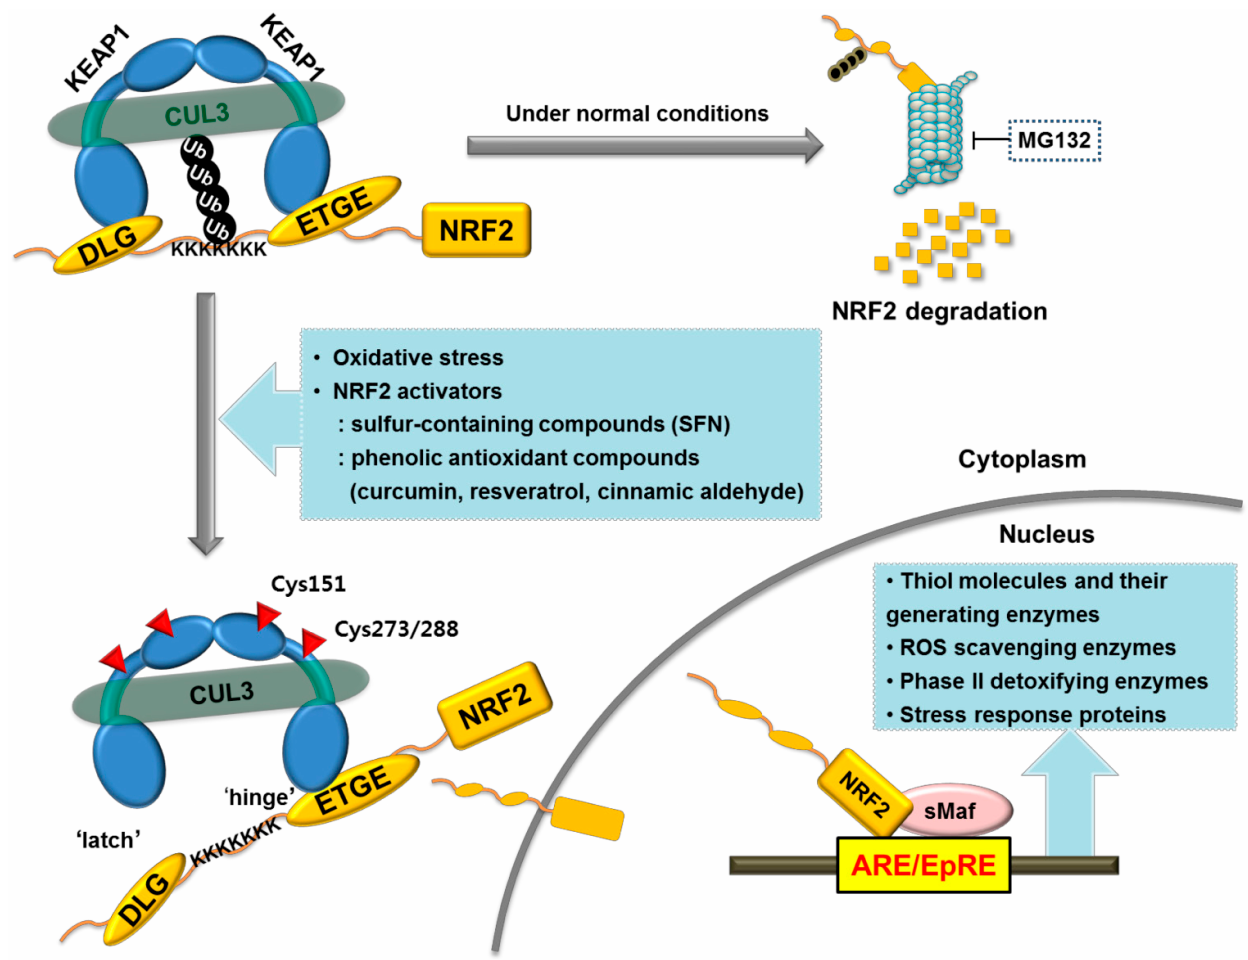
Figure 1. Regulation of antioxidant and detoxifying genes by the NRF2-Keap1 pathway. Under normal conditions, NRF2 is continuously degraded by the KEAP1-Cul3-proteasome axis. When Cys residues of KEAP1 protein are modified by sulfhydryl reactive chemicals, conformational KEAP1 changes lead to NRF2 liberation and transcriptional activation of an array of ARE-bearing genes, encoding detoxifying enzymes, ROS scavenging enzymes, thiol molecules, and their generating